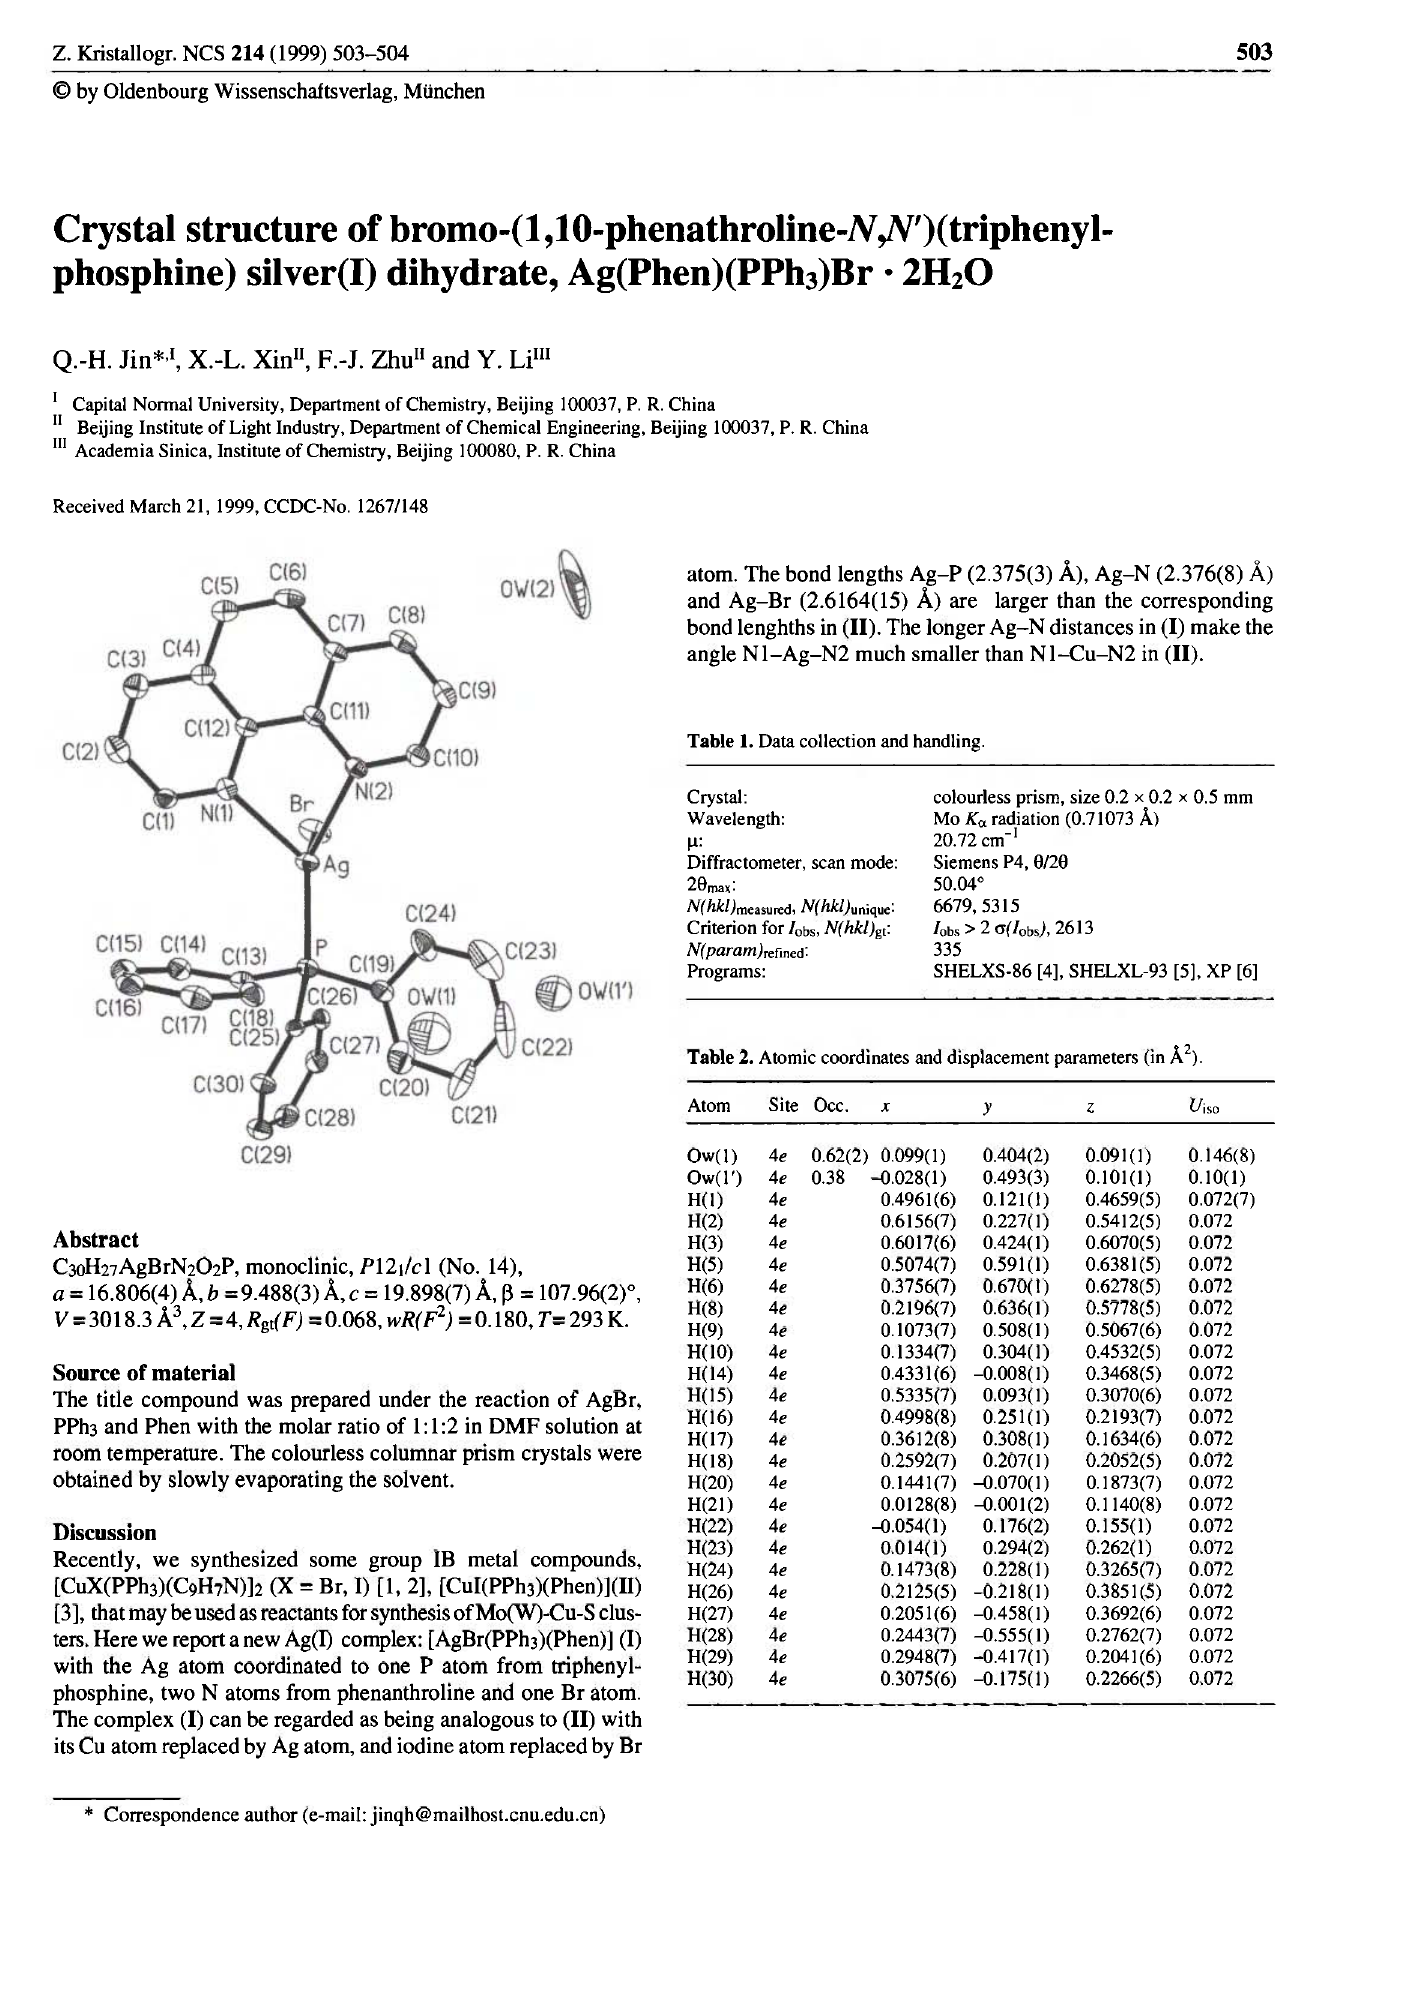
Table 1. Data collection and handling. Crystal: